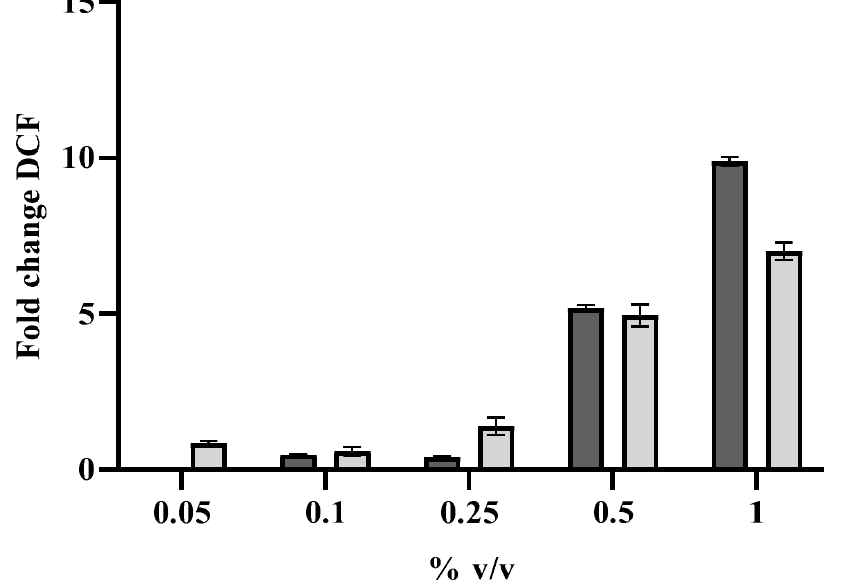
Figure 7. Increase in intracellular ROS in C. auris persister-derived biofilm following treatment with different concentrations of L. angustifolia free (dark grey) and liposome-encapsulated oil (light grey). Dichlorofluorescein (DCF) fluorescence values are normalized to biofilm biomass and expressed as DCF fold change with respect to untreated sample. Data are the mean of three independent experiments ±